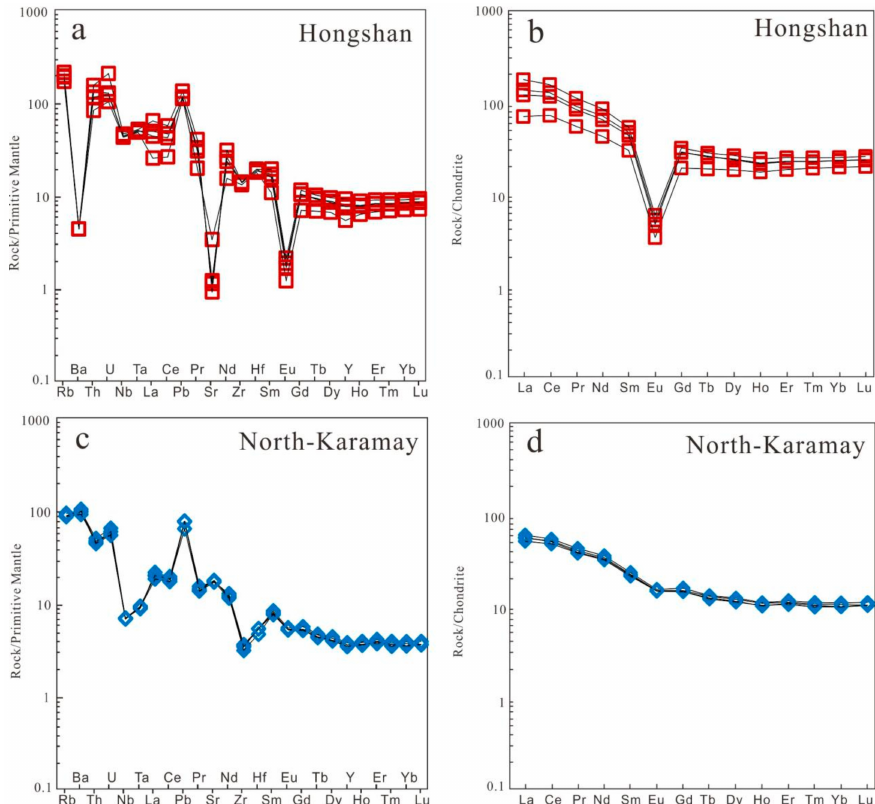
Figure 7. Primitive mantle-normalized trace element spider diagram ( a,c ) and chondrite-normalized REE diagram ( b,d ) for the studied granitoids in Western Junggar.Data of primitive mantle and chondrite are from Sun and McDonough [83].